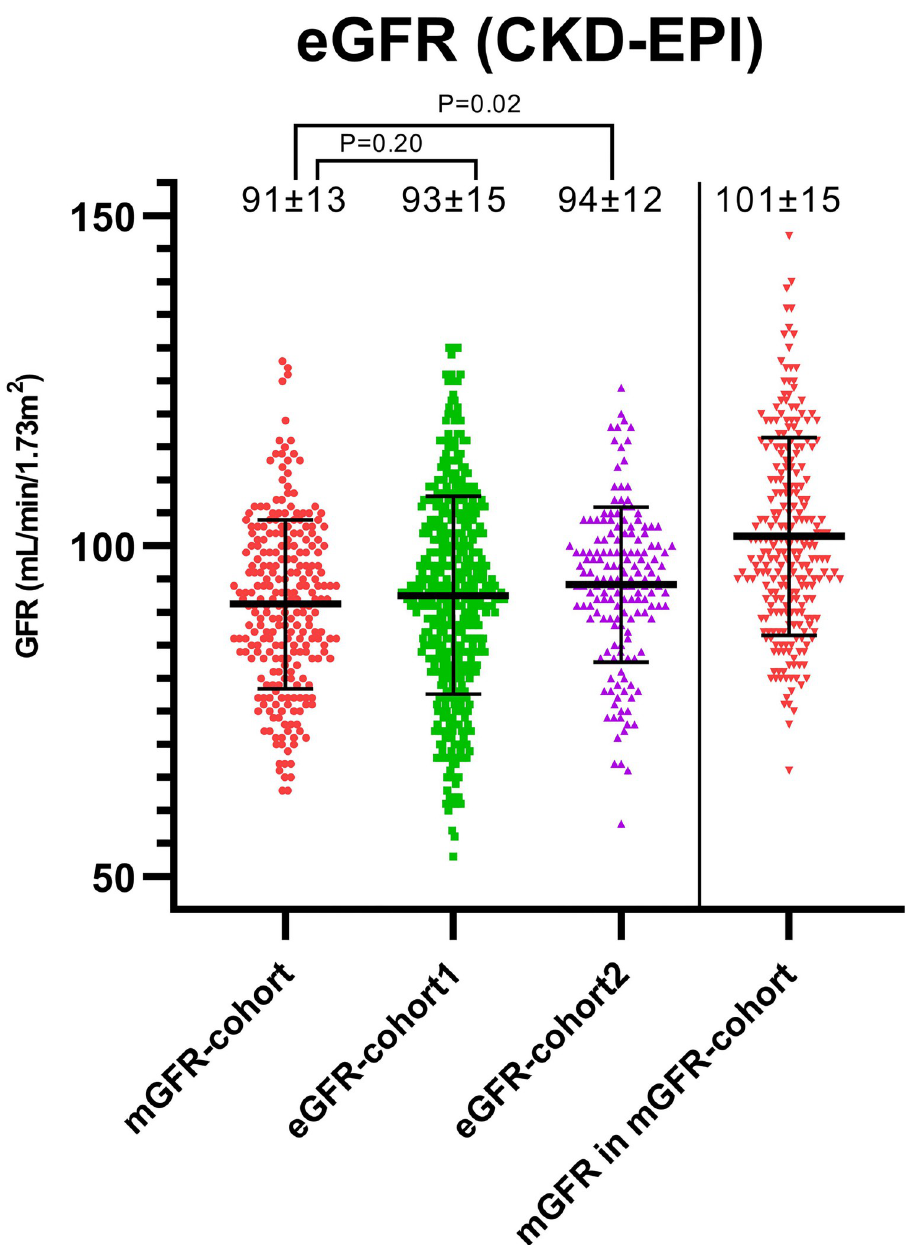
Fig 2. Distribution of pre-donation eGFR (CKD-EPI) per center. Differences between mean pre-donation eGFR were tested using the independent sample T-test, P-values are shown in the Fig. Distribution of mGFR in the mGFR- cohort was added on the right in the